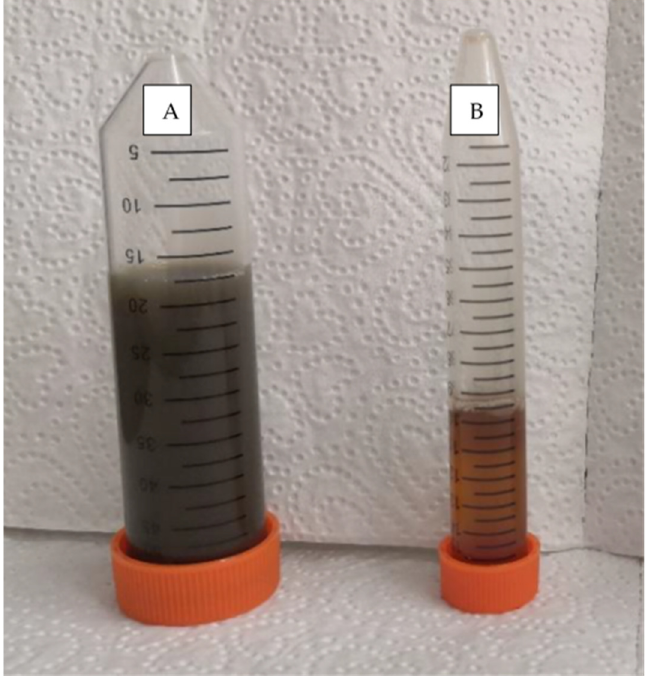
Figure 2. ( A ) MF feed and ( B ) MF permeate after microfiltration performance of site 2 manure.